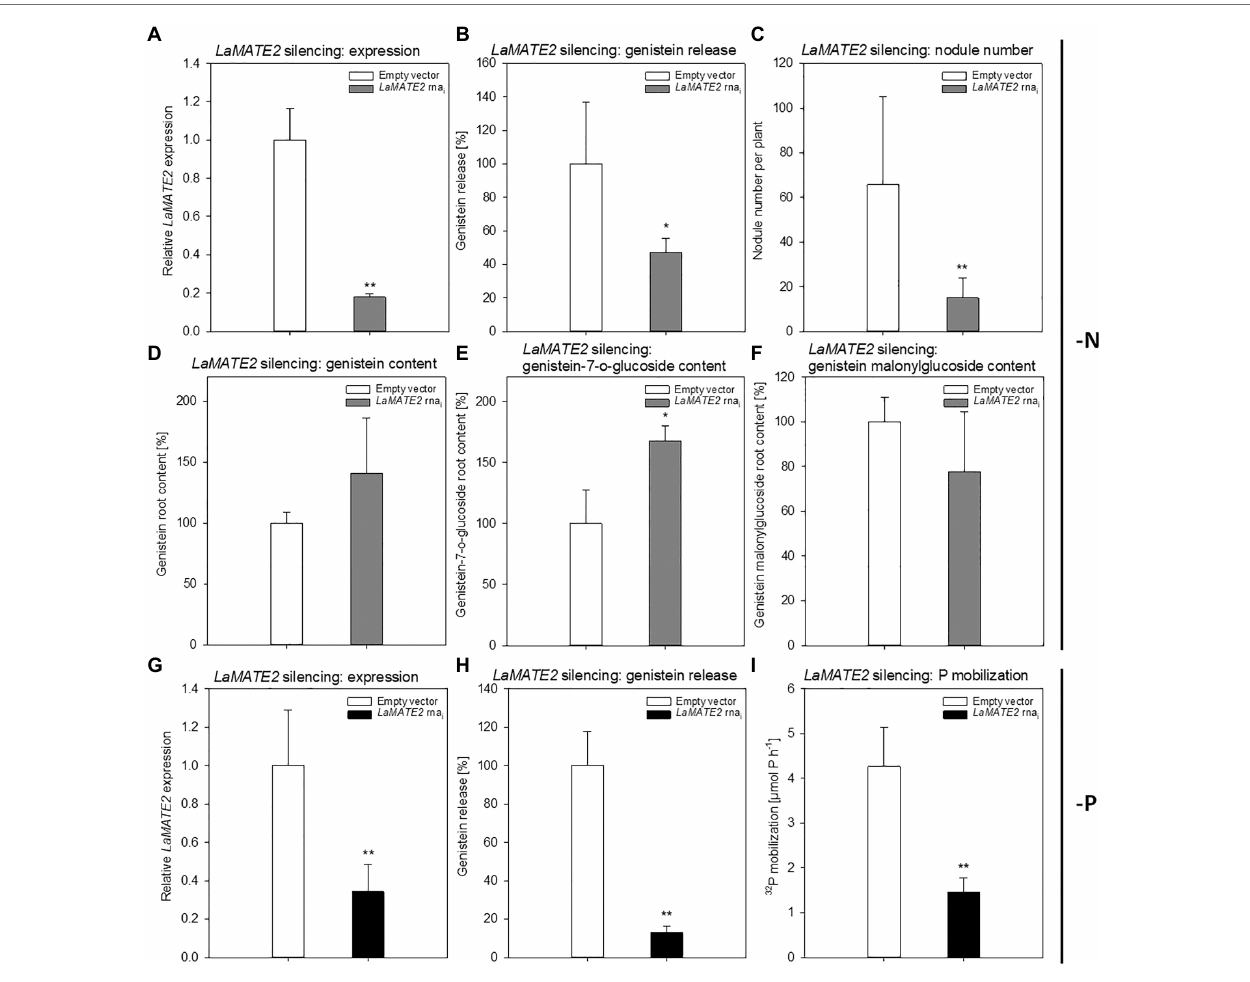
FIGURE 5 | Effect of LaMATE2 silencing in N and P deficient roots. Alteration of LaMATE2 expression, flavonoid content and release, nodule number or P mobilization due to LaMATE2 silencing in N (A-F) or P (G-I) deficiency. LaMATE2 relative expression (a, g; 6 biological replicates), genistein release (B,H) , number of nodules per plant (pictures shown in Supplementary Figure S4 ) (C) , cell content: genistein (D) , genistein 7-O-glucoside (E) , genistein malonylglucoside (F) , P mobilization from a poorly soluble P source (I) . The analyses were performed on roots of N- or P-deficient lupin plants independently transformed with either pRedRoot:: LaMATE2 RNAi ( LaMATE2 RNAi) or empty-vector pRedRoot (Empty vector). All data are expressed relative to Empty-vector-transformed roots, with the exceptions of the number of nodule per plants and P mobilization ( μ mol P h − 1 ). Data are mean + SD (Asterisks refers to statistically significant differences among the mean value of RNAi and Empty vector, ANOVA Holm–Sidak, N = 6–21, * p < 0.05; for ** p < 0.01; with 3 technical replicates for each real-time